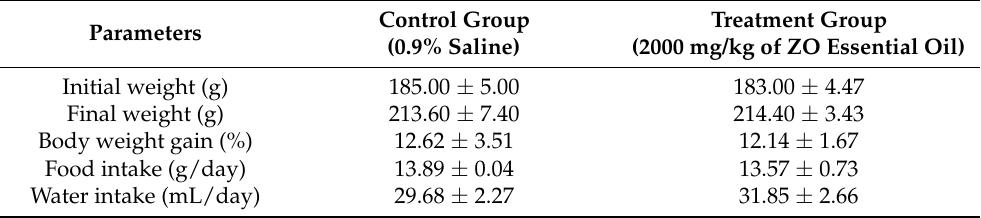
Table 4. Body weight and food and water intake of the control group (0.9% saline) and the treatment group (2000 mg/kg of ZO essential oil) during the 14 day observation period. Data shown are the